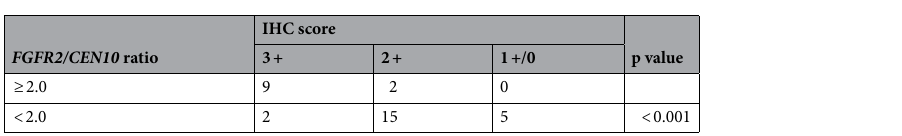
Table 2. Correlation between FGFR2/CEN10 ratio and intensity of immunohistochemical staining.